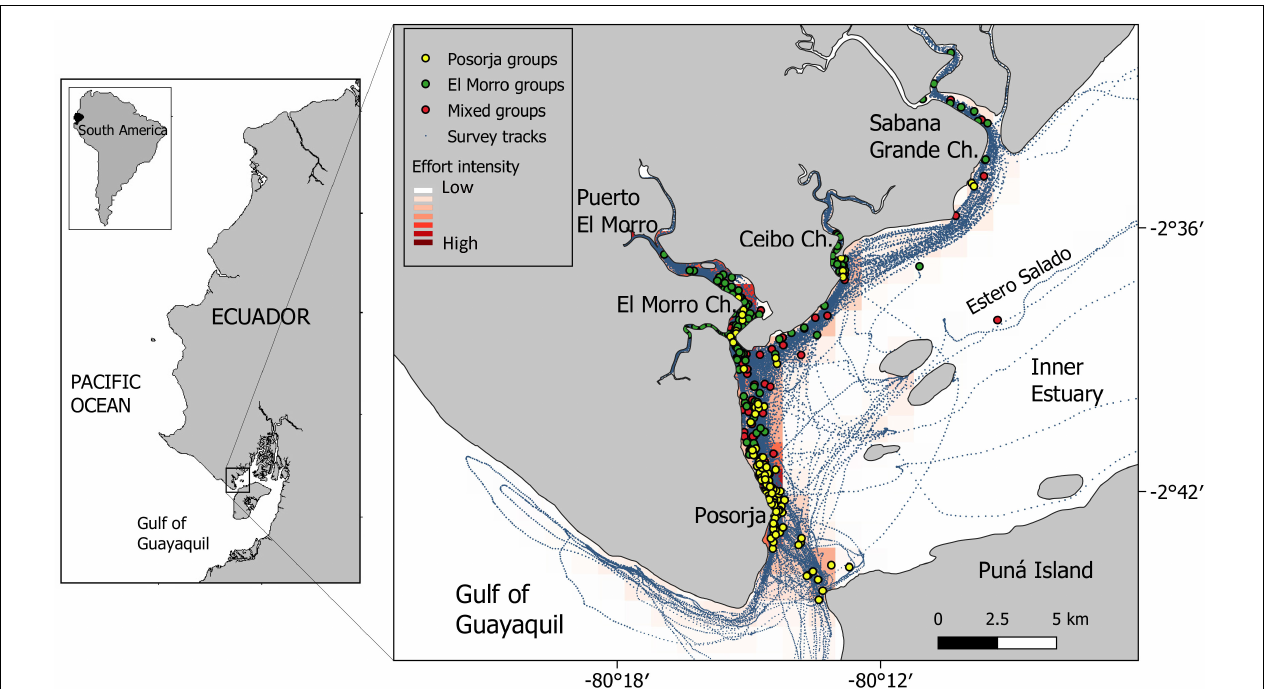
FIGURE 1 | The study area in the western part of the inner estuary of the Gulf of Guayaquil. Blue lines correspond to the survey tracks conducted during the study period. Colored dots correspond to geo-referenced positions where dolphin groups were recorded, and the colors indicate their membership (Posorja, El Morro and mixed groups). The red-colored background layer shows the effort